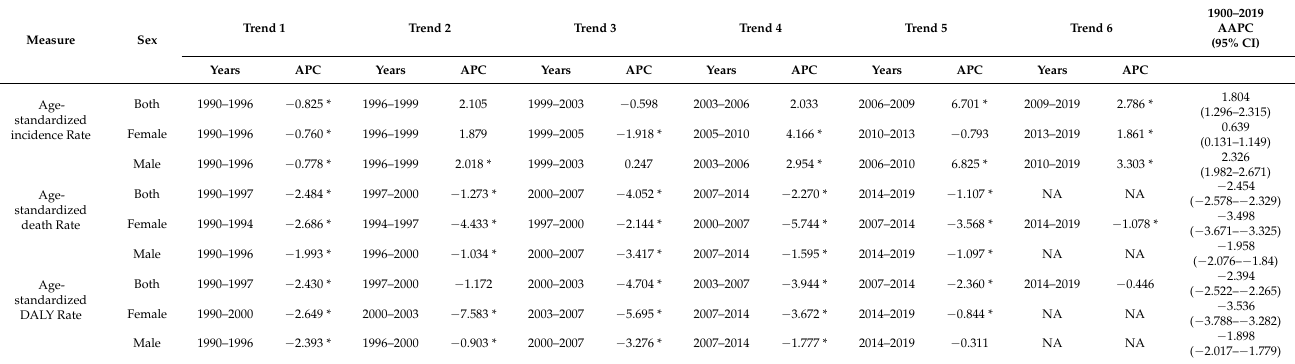
Table 1. Log-transformed joinpoint trends of Nasopharyngeal carcinoma ASRs by sex in